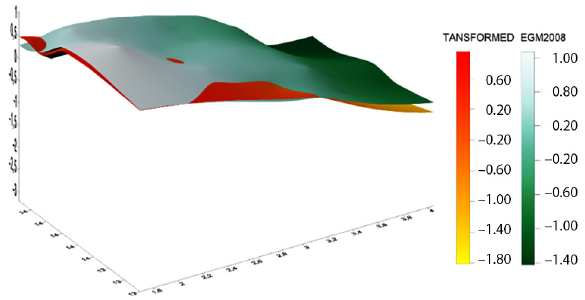
Fig. 11. 3D view of EGM2008 (green) and transformed geometric (red) geoids